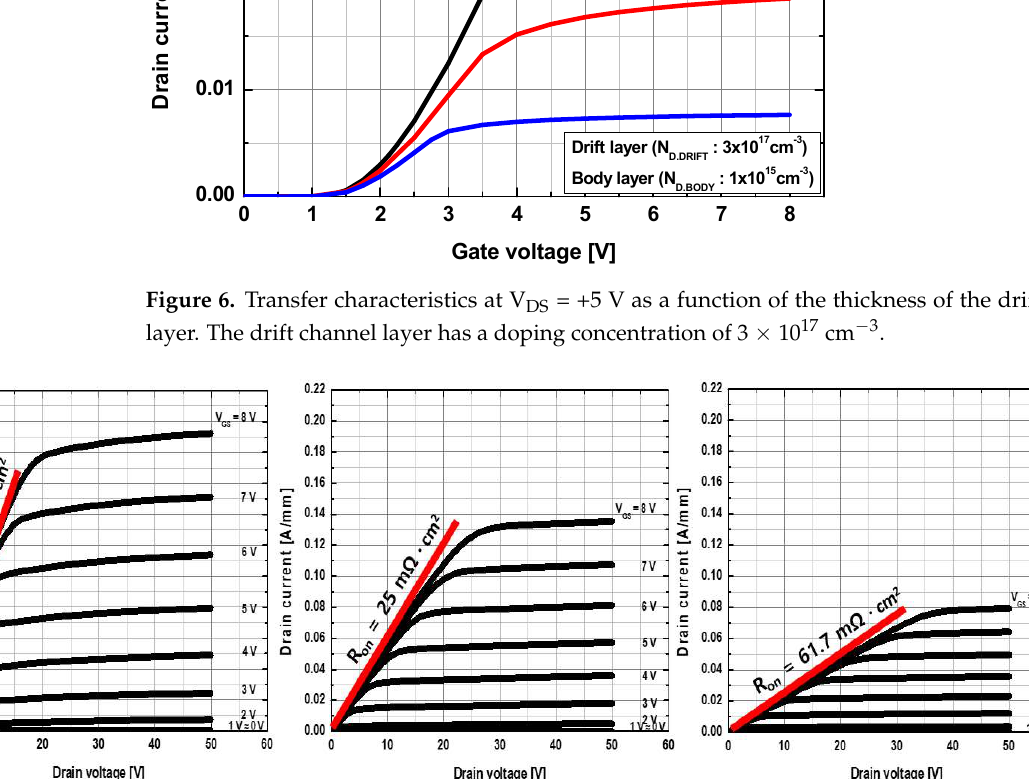
Figure 7. Output current–voltage characteristics for a drift channel layer thickness of ( a ) 300 nm, ( b ) 150 nm, and ( c ) 75 nm. The drift channel layer has a doping concentration of 3 × 10 17 cm −3 .